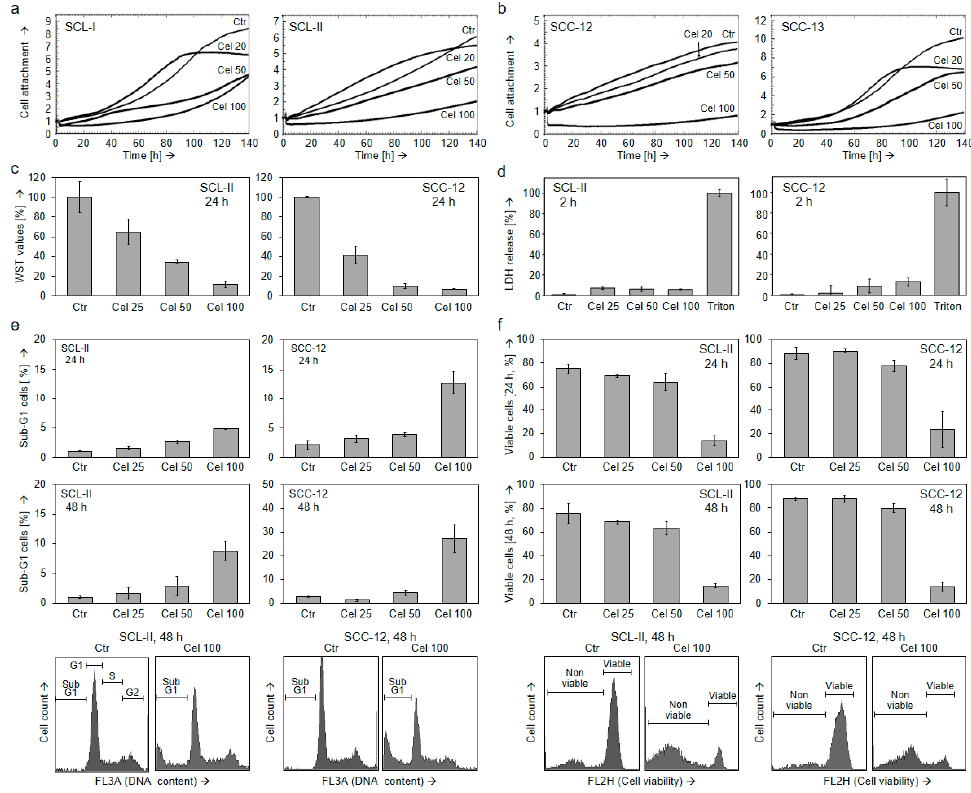
Figure 1. Decreased cell proliferation by celecoxib despite little effects on apoptosis. ( a , b ) Real-time cell analysis (RTCA) of ( a ) squamous cell carcinoma cell lines SCL-I and SCL-II as well as ( b ) of squamous cell carcinoma cell lines SCC-12 and SCC-13 treated with 20, 50, and 100 µ M celecoxib (time 0 h = start of treatment). The determined cell index gives a relative measurement of cell attachment. The experiment was performed twice with triple values, which revealed highly comparable results. ( c ) Cell proliferation was quantified by WST-1 assay in SCL-II and SCC-12 at 24 h of celecoxib treatment (25, 50, 100 µ M). ( d ) Direct cytotoxicity was determined in SCL-II and SCC-12 at 2 h of treatment by quantification of lactate dehydrogenase (LDH)-release (fold change of non-treated controls, set to 1). Cells treated with triton x100 (0.7%) were used as positive controls. ( e , f ) Apoptosis ( e ) and cell viability ( f ) were determined in SCL-II and SCC-12 at 24 h and at 48 h in response to 25, 50, and 100 µ M celecoxib. Apoptotic cells were identified in cell cycle analyses as sub-G1 cells characterized by DNA fragmentation, whereas cell viability was determined by calcein-AM staining. Examples of flow cytometry measurements are given below. ( c – f ) Mean values are shown in representative experiments. At least two independent experiments, each one with triplicates, revealed highly comparable results.